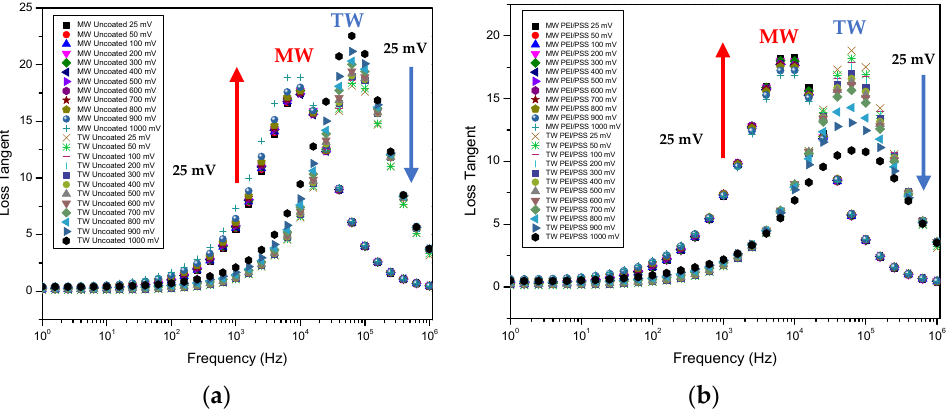
Figure 6. Loss tangent spectra for ( a ) uncoated sensors and ( b ) coated with a (PEI/PSS) 5 film, for both mineral and tap water. Red and blue arrows indicate the evolution of the voltage values, from 25 mV up to 1000 mV. The relative error is less than 1%.